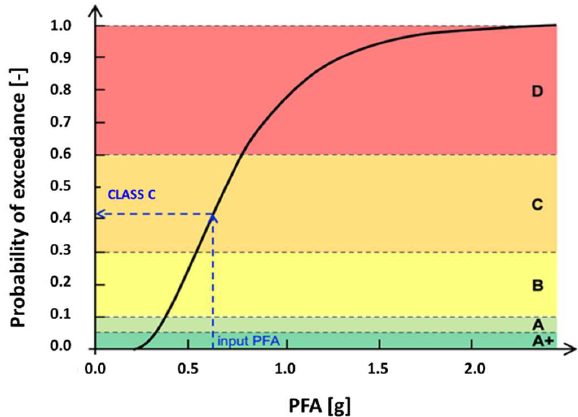
Figure 2. Graphical representation of seismic risk evaluation for a generic nonstructural element, according to the proposed approach.